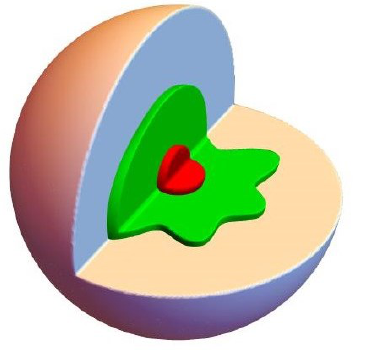
Figure 17. Computational geometry and interface.